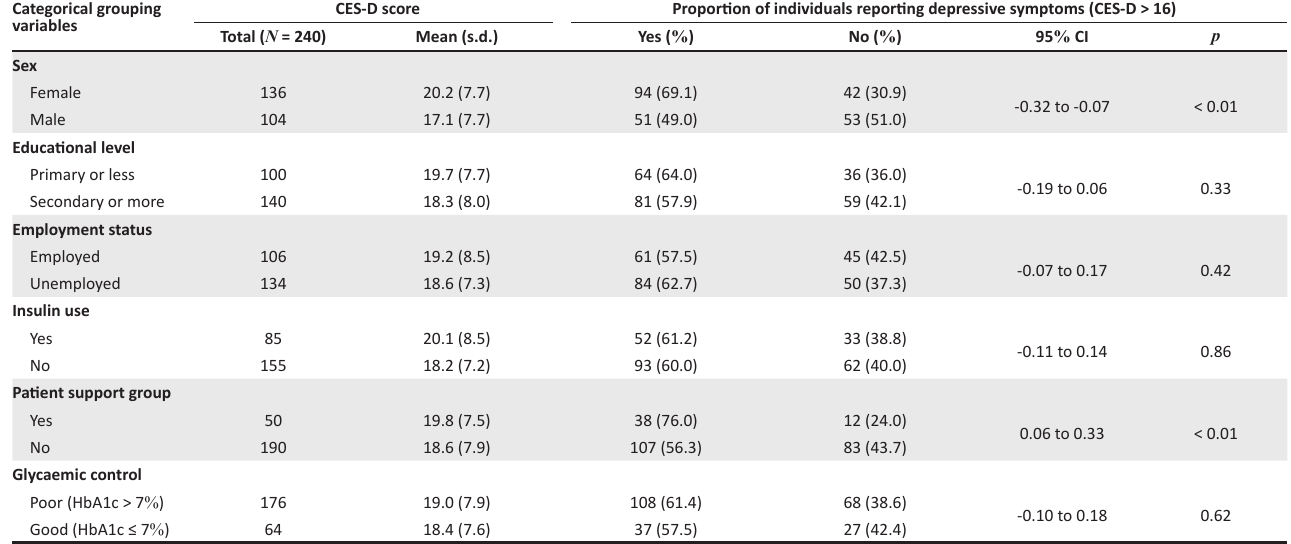
TABLE 3: Baseline characteristics of study population analysed against Centre for Epidemiological Studies Depression Scale (CES-D) score. Categorical grouping